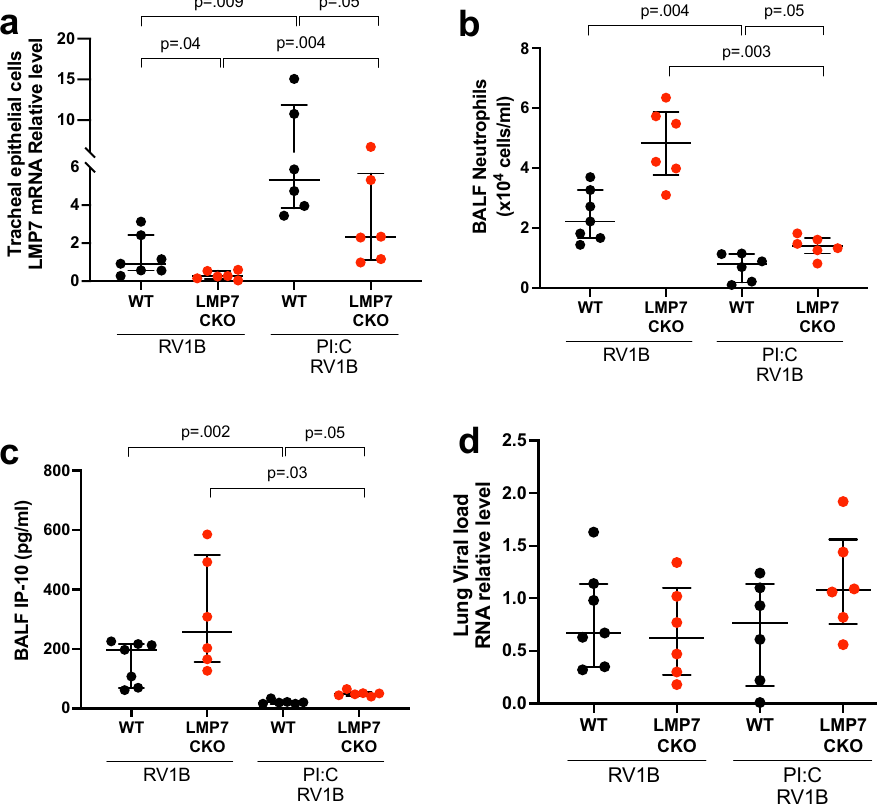
Figure 5. A low dose of PI:C upregulates airway epithelial LMP7 and reduces neutrophilic inflammation in RV-infected LMP7 conditional knockout mice . Mice were fed with tamoxifen chow for 7 days, and then regular chow for another 7 days. Mice were treated with 2 μg/mouse PI:C or PBS via intranasal inoculation for 24h followed by RV1B at 5 × 10 6 PFU/mouse or 0.1% BSA-PBS (PBS). Mice were sacrificed at 24h post infection. ( A ) LMP7 mRNA relative levels in isolated tracheal epithelial from individual mice were normalized to 18S rRNA gene. ( B ) Total number of neutrophils in BALF. ( C ) IP-10 levels in BALF. ( D ) RV load was measured in the lung by RT-PCR and normalized to 18S rRNA gene. Data were analyzed using Kruskal–Wallis test. n = 5–7 mice per